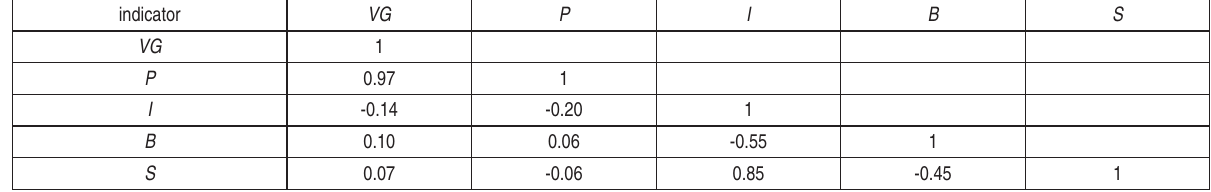
Table 5. Matrix of correlation coefficients pairs for calculation of inter - economic credits